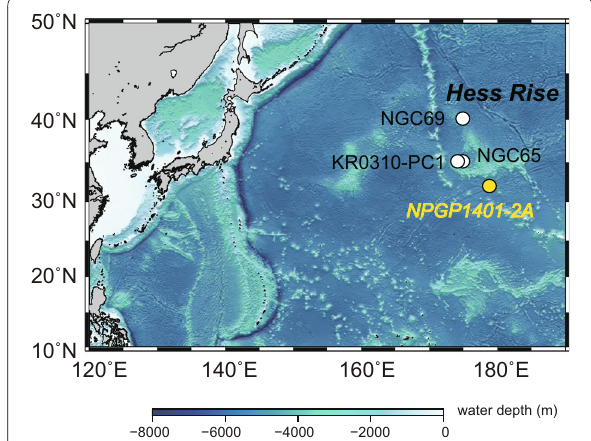
Fig. 1 Locations of the studied sediment core NPGP1401-2A (yellow dot) and reference cores (white dots). NGC69 and NGC65: Yamazaki (1999); KR0310-PC1: Yamazaki and Kanamatsu